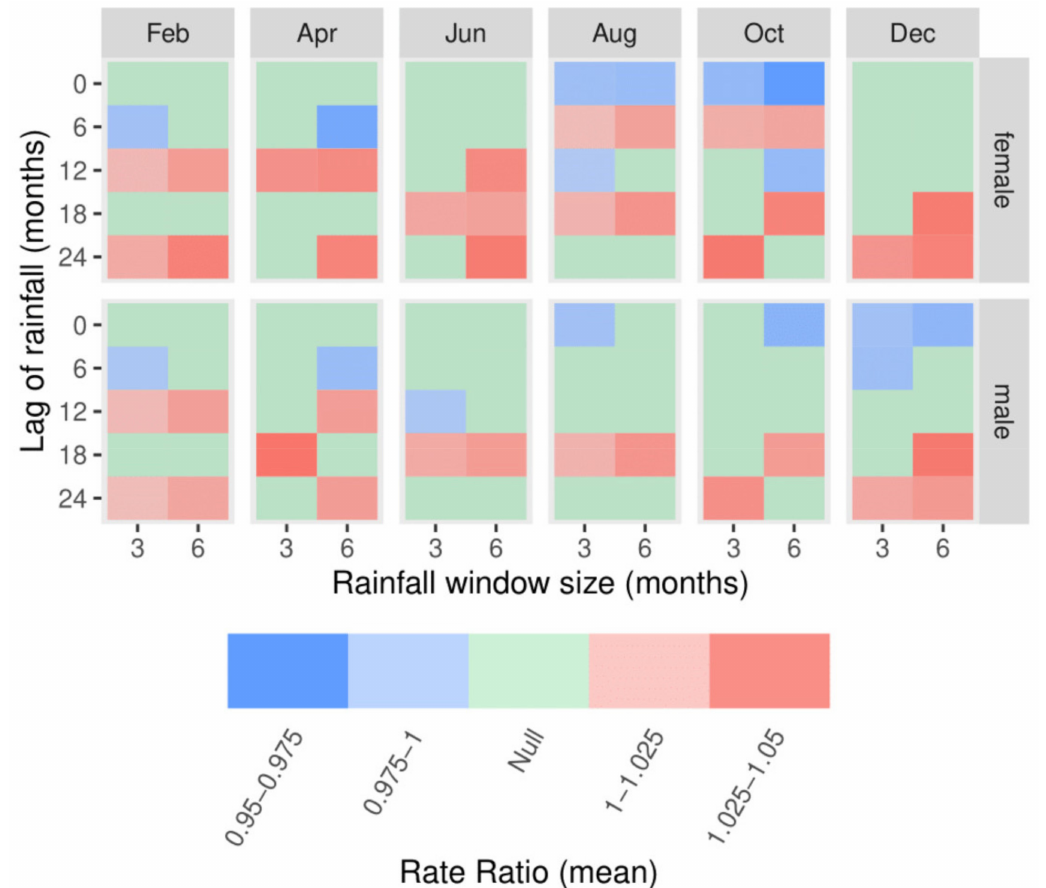
Figure 8. Mean RRs amongst regressions on all spatial